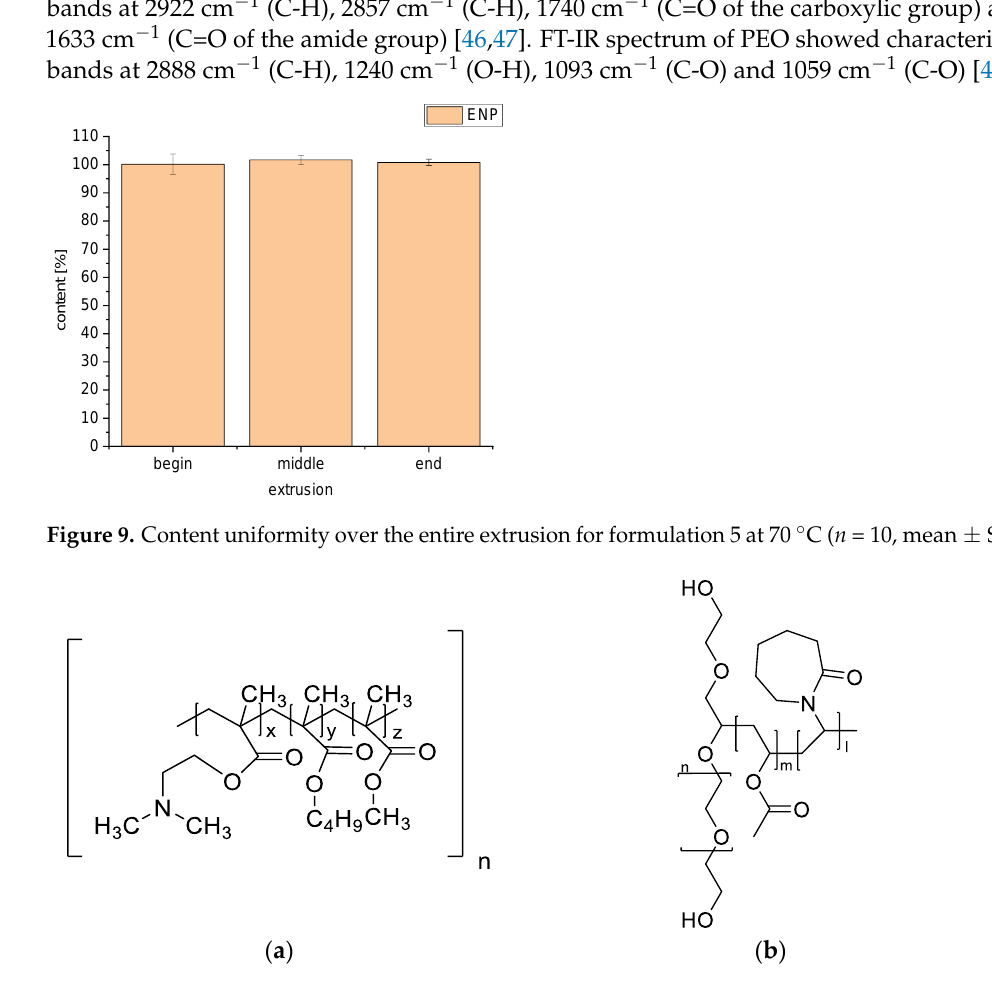
Figure 11. FT-IR spectra for formulations 5 ( a ) and 6 ( b ).